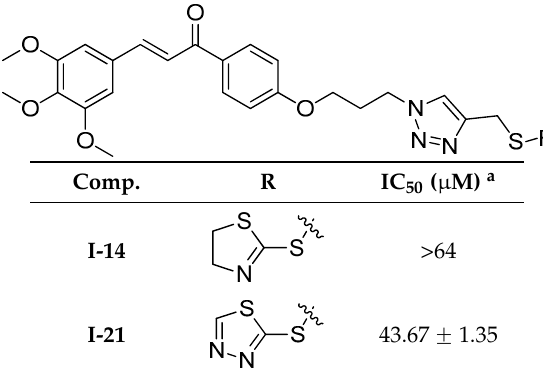
Table 2. Inhibitory results of chalcone-1,2,3-triazole-azoles against GES-1 cell lines. Comp.